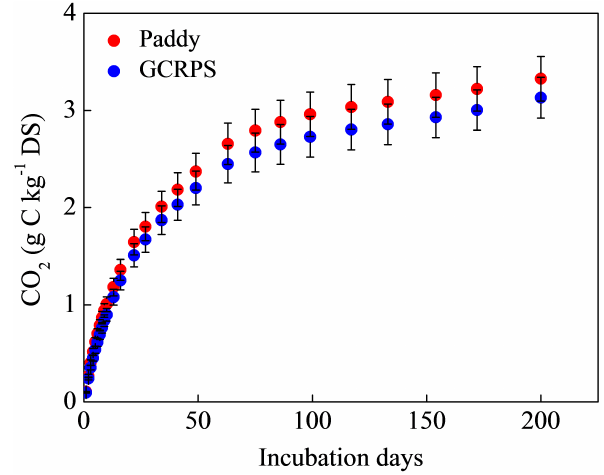
Figure 5. Differences in cumulative organic carbon mineralization during a 200-day incubation period of top soils (0–20cm) collected from either paddy sites or GCRPS. Data presented are the mean values pooled over 49 paired sites. Error bars indicate SEM.